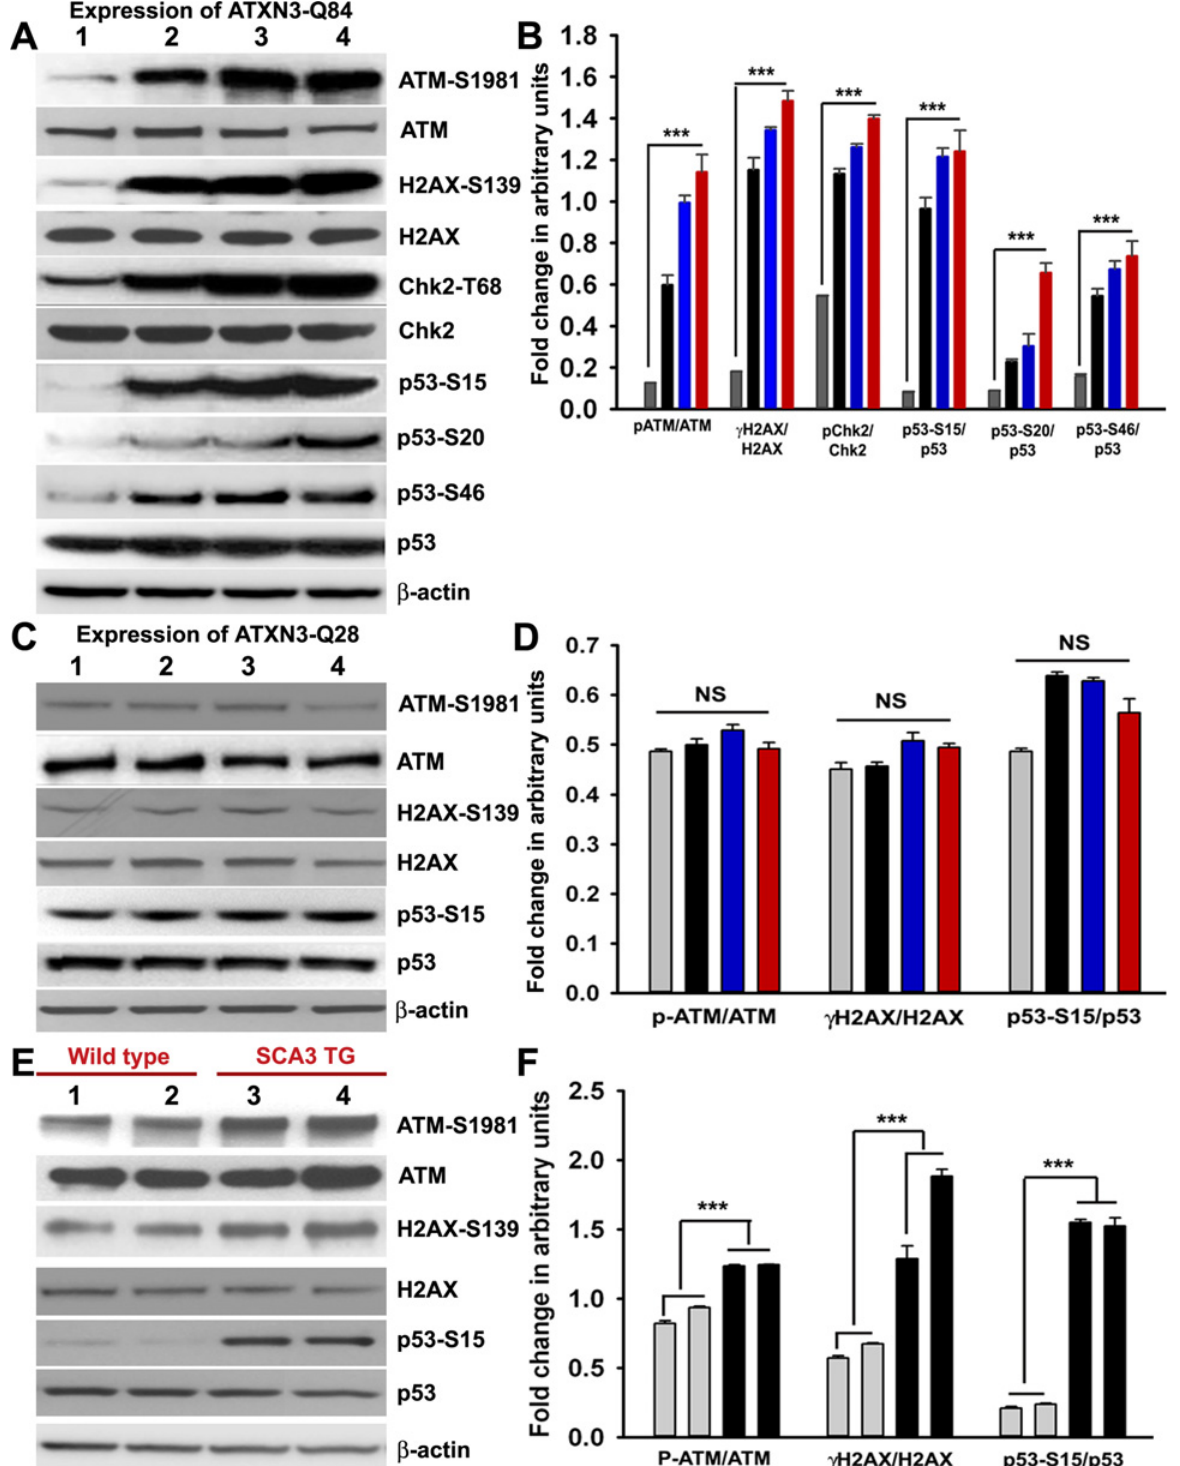
Figure 4. Mutant ATXN3 activates DNA damage-response in vitro and in vivo . (A) Expression of ATXN3-Q84 was induced in differentiated SH-SY5Y cells; cells were harvested 0, 3, 6 and 12 days post-induction (lanes 1 to 4) and their lysates analyzed by Western blotting to determine the levels of ATM- S1981, total ATM, γ H2AX-S139, total H2AX, Chk2-T68, total Chk2, p53-S15, p53-S20, p53-S46 and total p53; β -actin was used as the loading control in A, C and E. (B) Levels of ATM-S1981, γ H2AX-S139, Chk2-T68, p53-S15, p53-S20 and p53-S46 relative to their respective total protein levels in cells